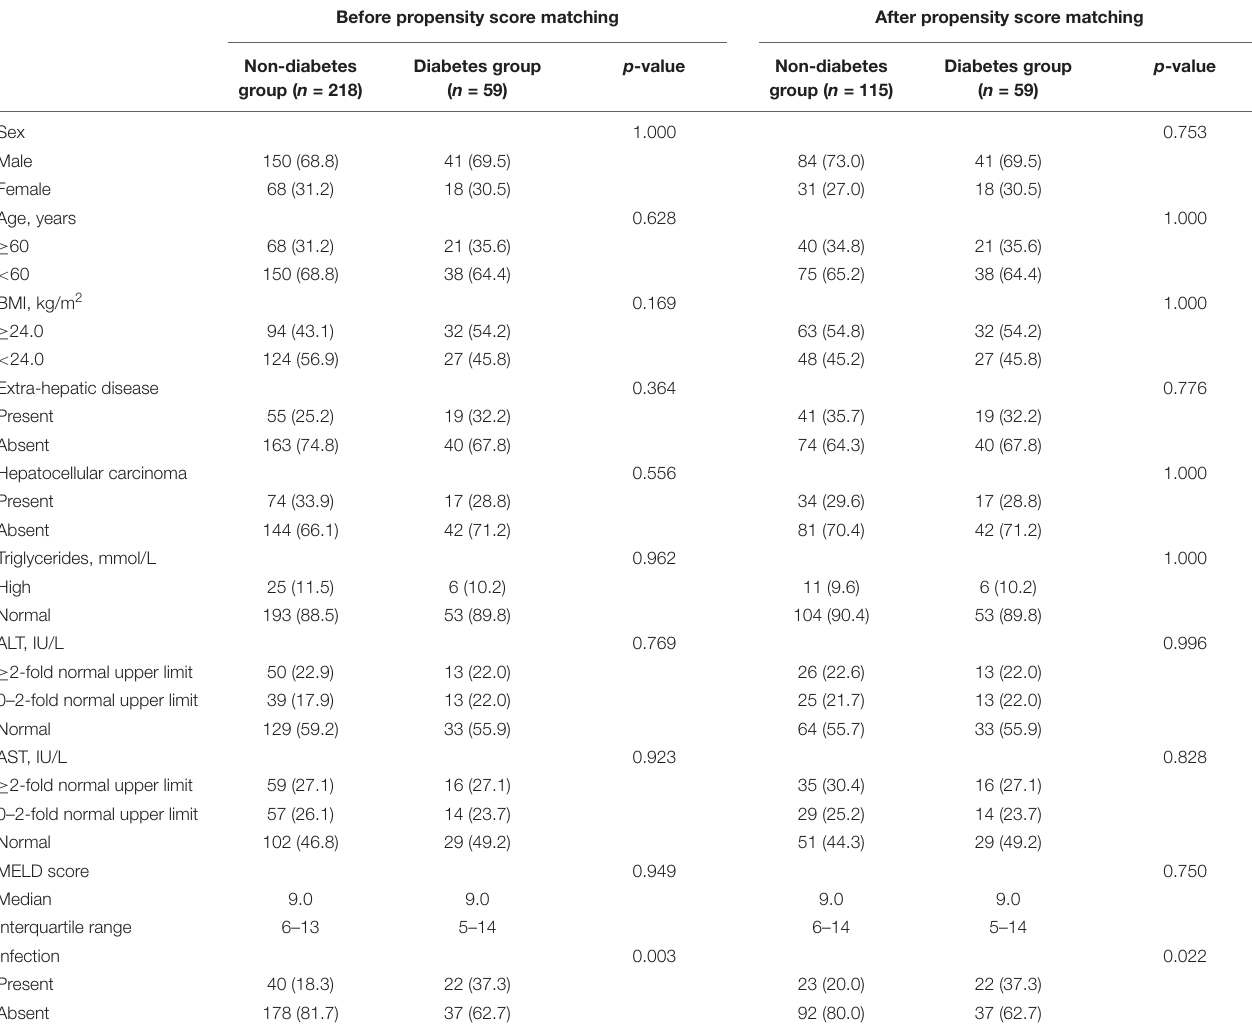
TABLE 3 | Clinical characteristics stratified by DM in patients with low HDLC. Before propensity score